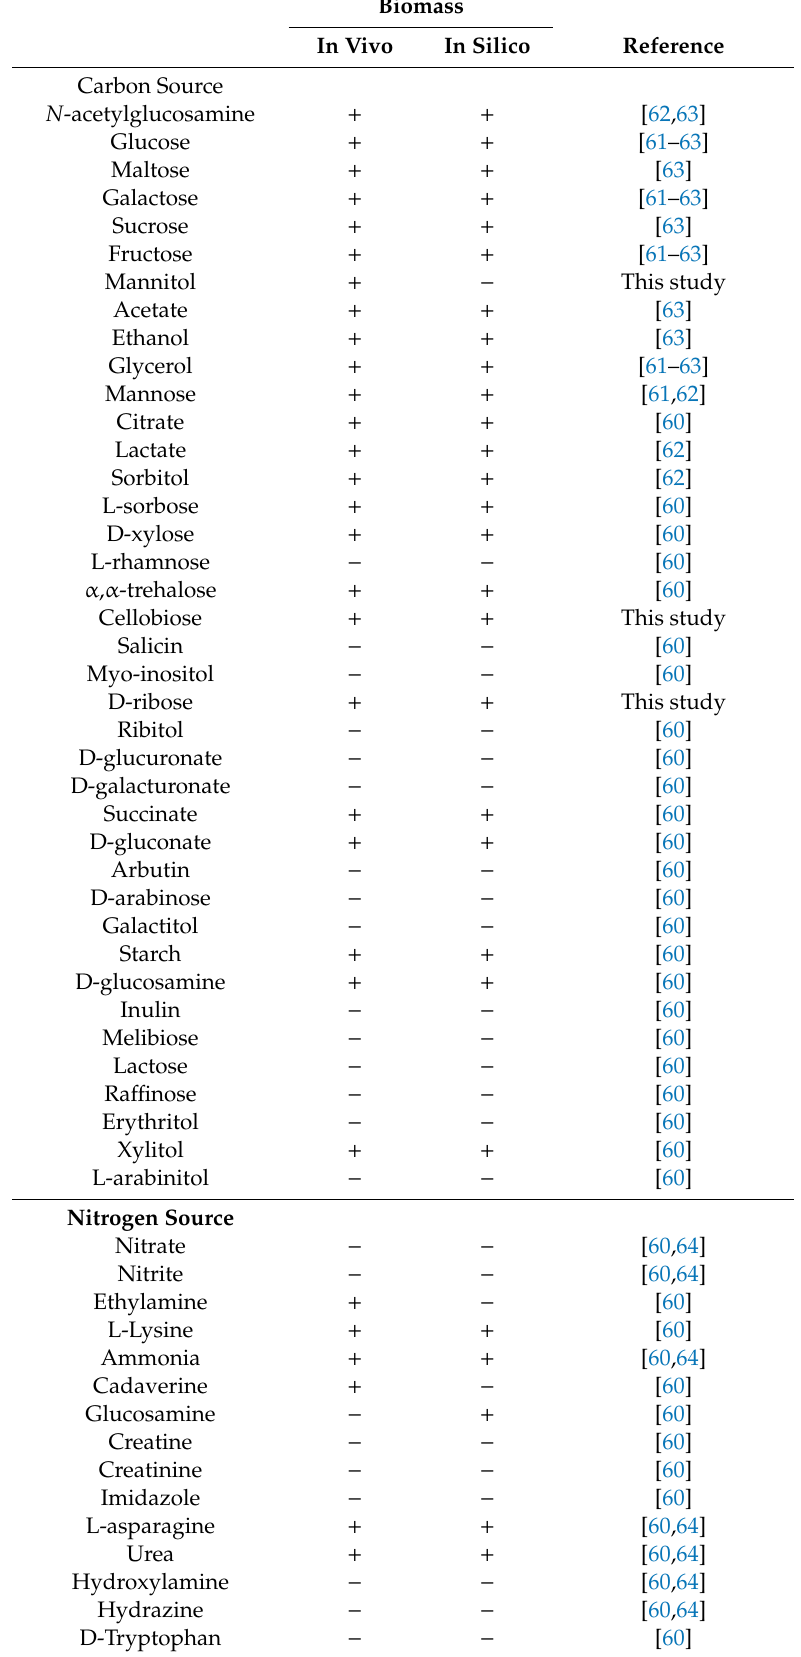
Table 3. Comparison between in vivo and in silico phenotypic behavior of C. albicans under di ff erent carbon and nitrogen sources. Growth ( + ); lack of growth ( −